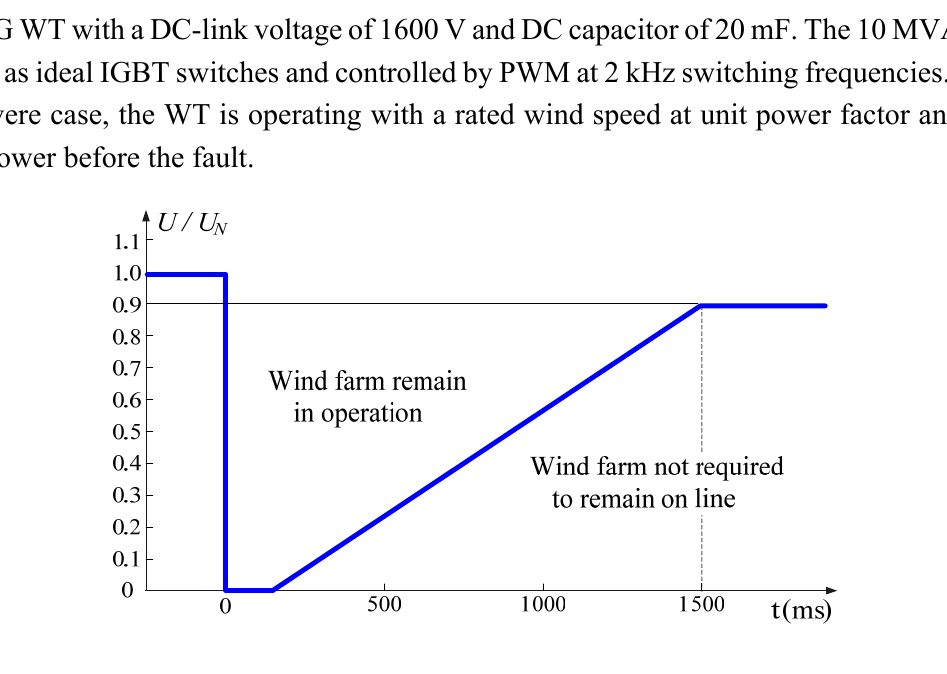
Figure 15. LVRT requirement of E.ON grid code during grid fault.